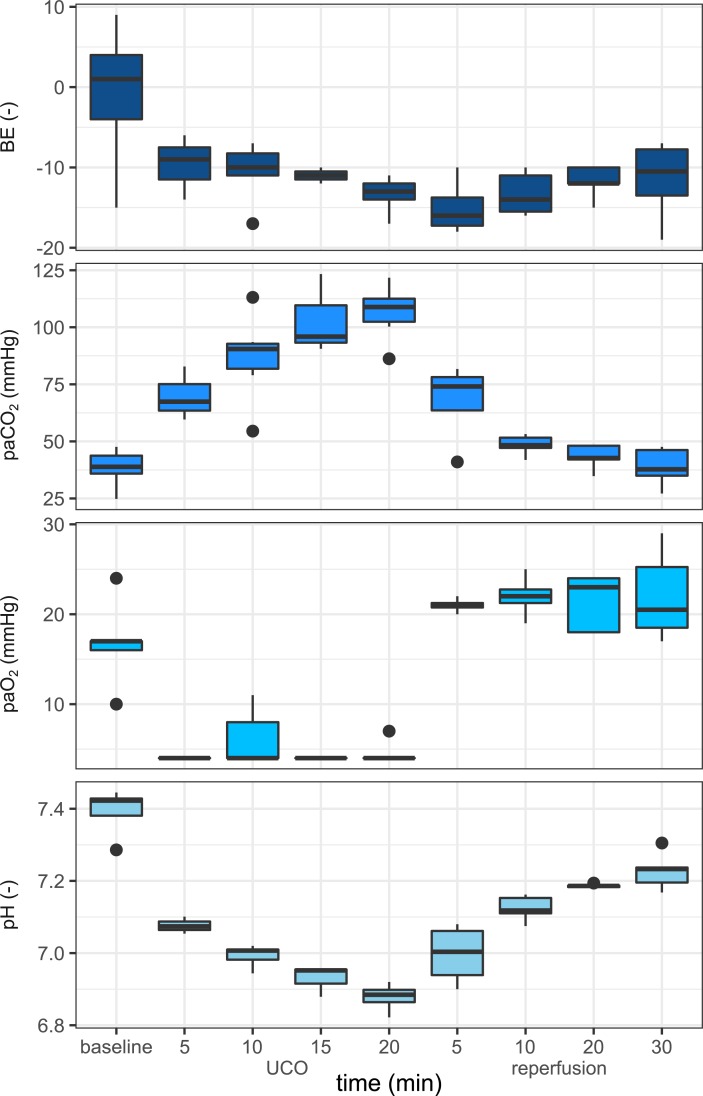
Blood gas analysis during normoxemia and hypoxemia.Whisker plots for arterial blood pH (panel A), base excess (panel B), partial arterial oxygen pressure (panel C) and partial arterial carbon dioxide pressure (panel D), with whiskers extending up to 1.5 times IQR. Blood gasses were assessed during baseline, during (5-10-15-20 minute) umbilical cord occlusion and during reperfusion. Outliers are displayed as circles.